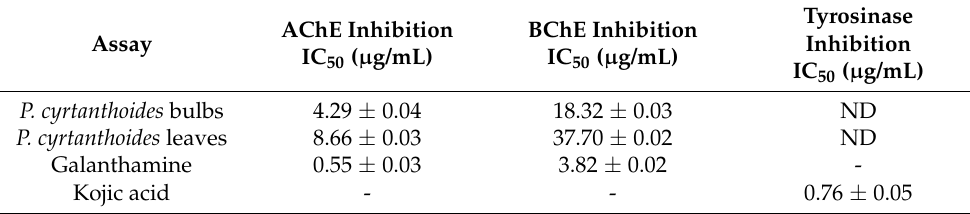
Table 2. Enzymatic inhibitory activity of Phycella cyrtanthoides alkaloid extracts. AChE Assay